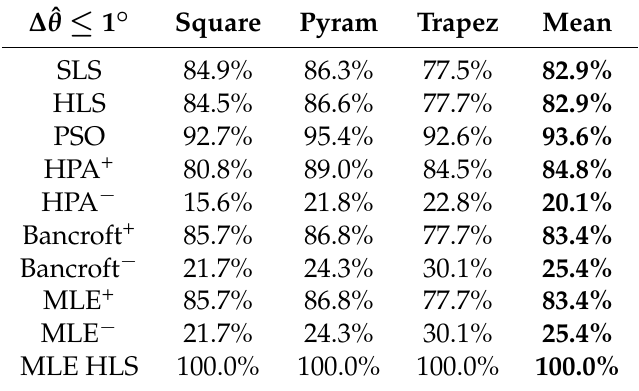
Table 3. Percentage of positions analysed located with an elevation angle error ∆ ˆ θ less than 1 ◦ under theoretical conditions for each algorithm and antenna array configuration.